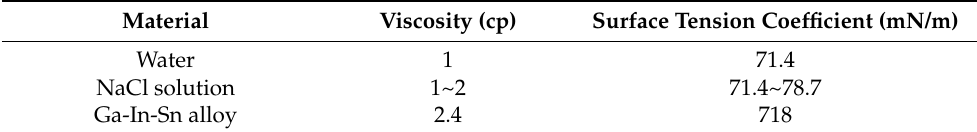
Figure 2. Diagram of the keyhole behavior observation experimental setup: ( a ) Keyhole observation in analogy welding; ( b ) Keyhole observation in real deep penetration laser welding with sandwich method.